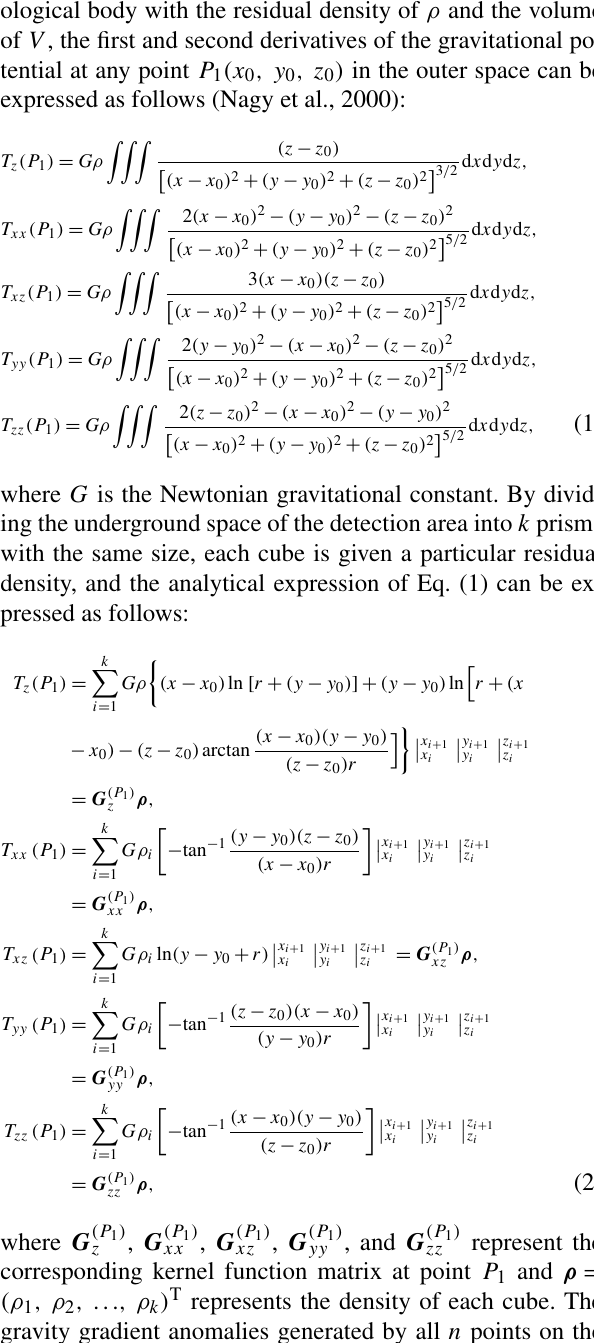
(ρ 1 , ρ 2 , ..., ρ k ) T represents the density of each cube.